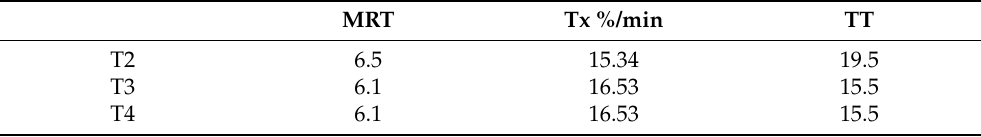
Table 4. Mean retention time (MRT), passage rate (Tx %/min) and total passage time (TT) of the markers in Artemia , after Faichney’s model.